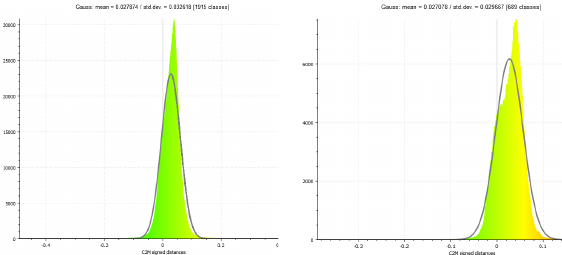
Figure 16a. C2M Scalar histogram cloud to mesh. Figure 16b. M2M Scalar